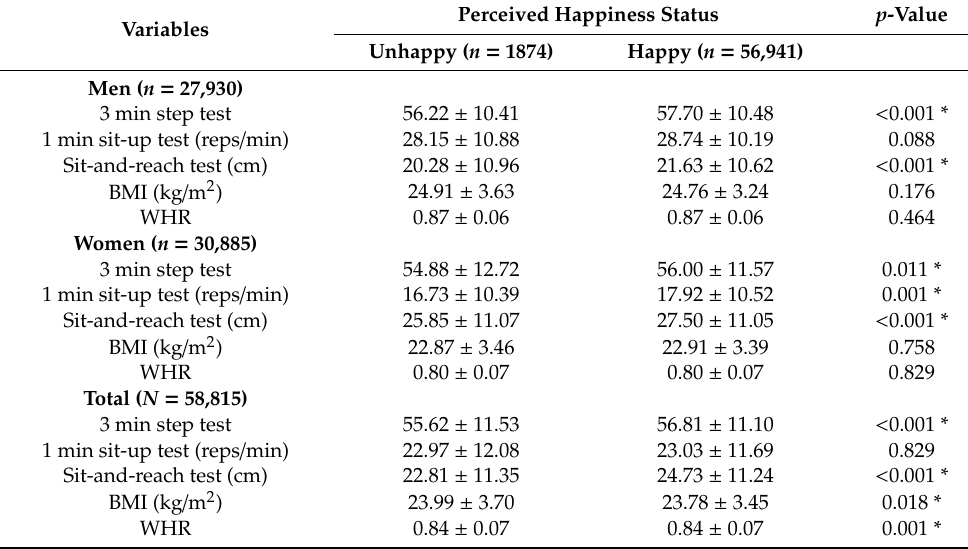
Table 2. The comparison of health-related physical fitness measurements between happy and unhappy groups in Taiwanese adults.